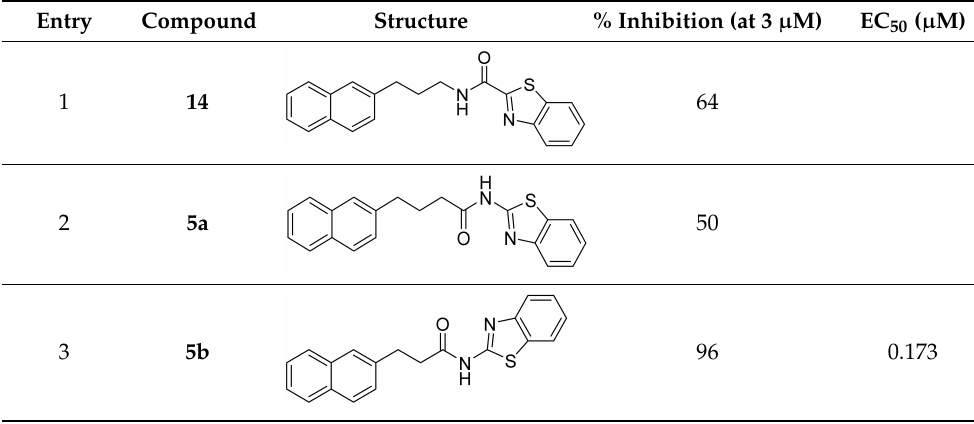
Table 1. Inhibition of PGE 2 generation by N -acylated 2-aminobenzothiazoles and related